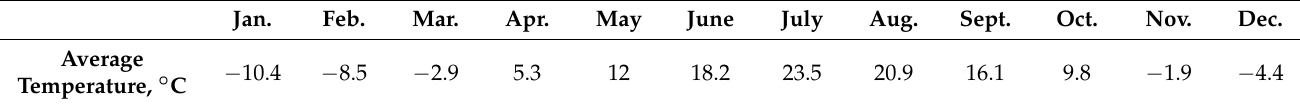
Table 3. Montreal monthly average temperature in